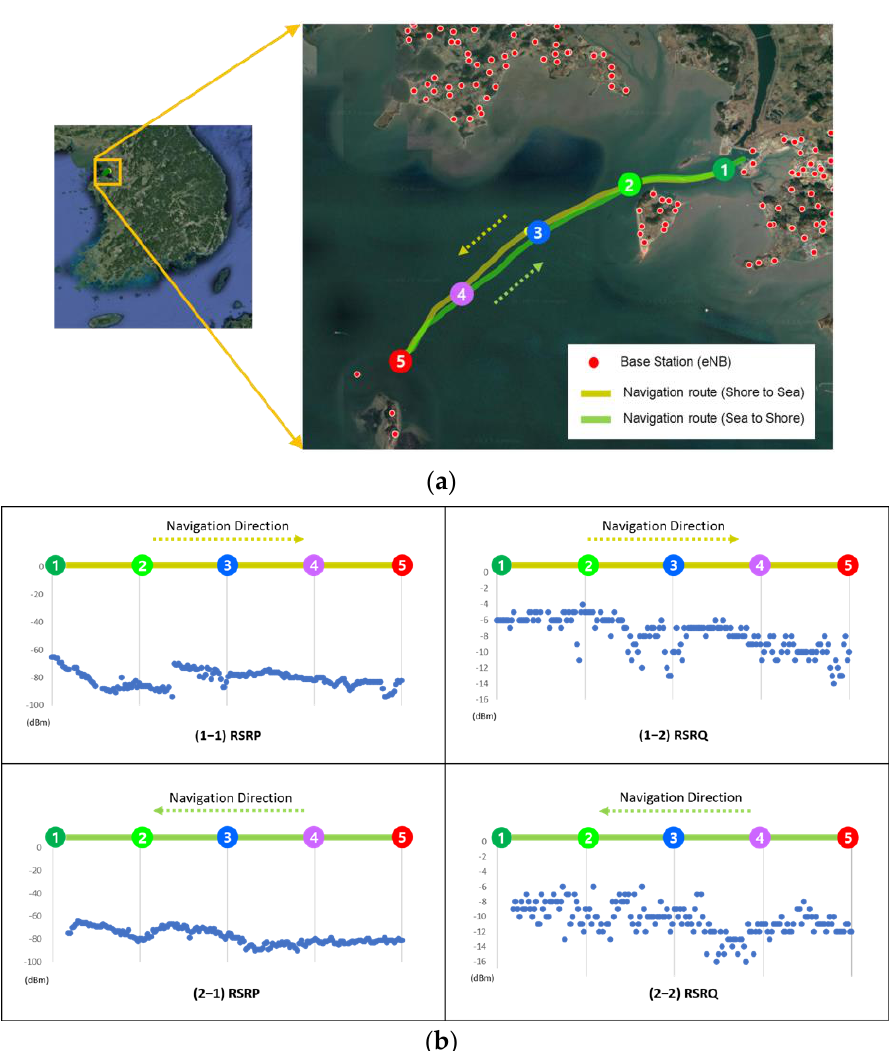
Figure 17. Round trip time measured from VSAT end-device at KTSAT Kumsan satellite service center, in Kumsan, Republic of Korea.